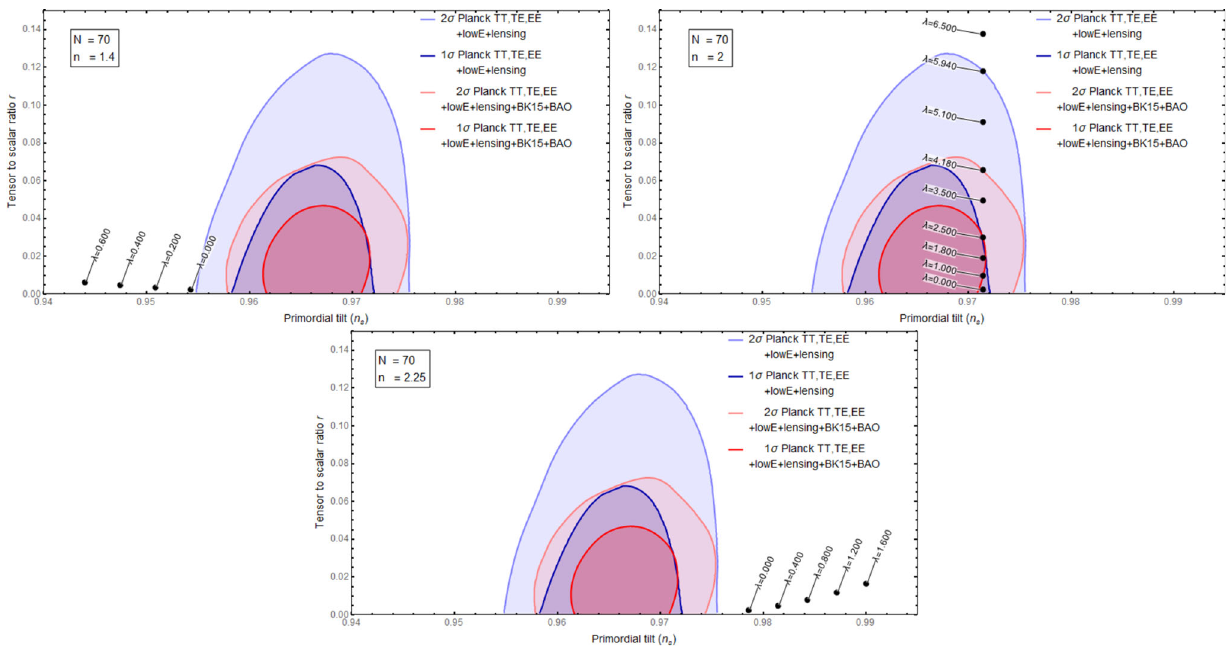
Fig. 2 We compare the theoretical predictions in the ( r − n s ) plane for different values of λ using N = 70 and varying n . We plots for N = 70 , n = 1 . 40 (upper-left panel); N = 70 , n = 2 (upper-right